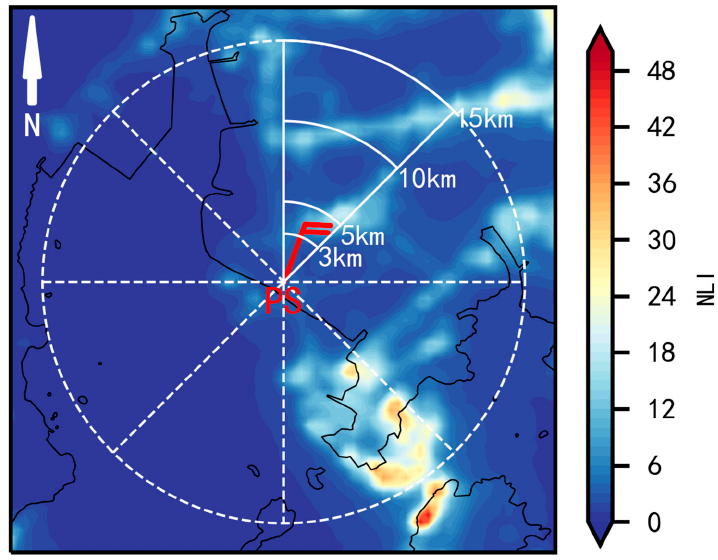
Figure 2. Schematic diagram of the fan-sector method.